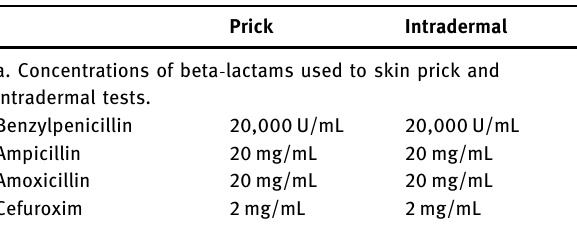
Table 1: Concentrations of drugs used for skin prick and intradermal tests